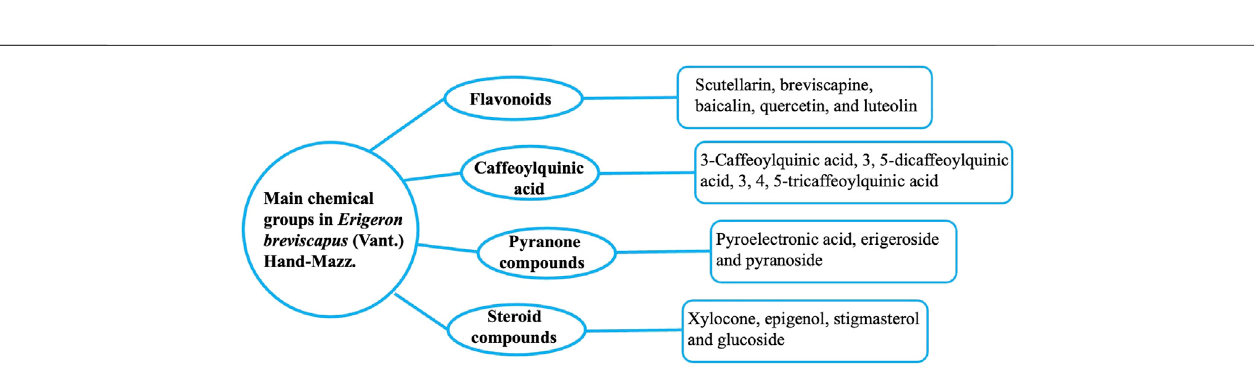
Frontiers in Pharmacology |